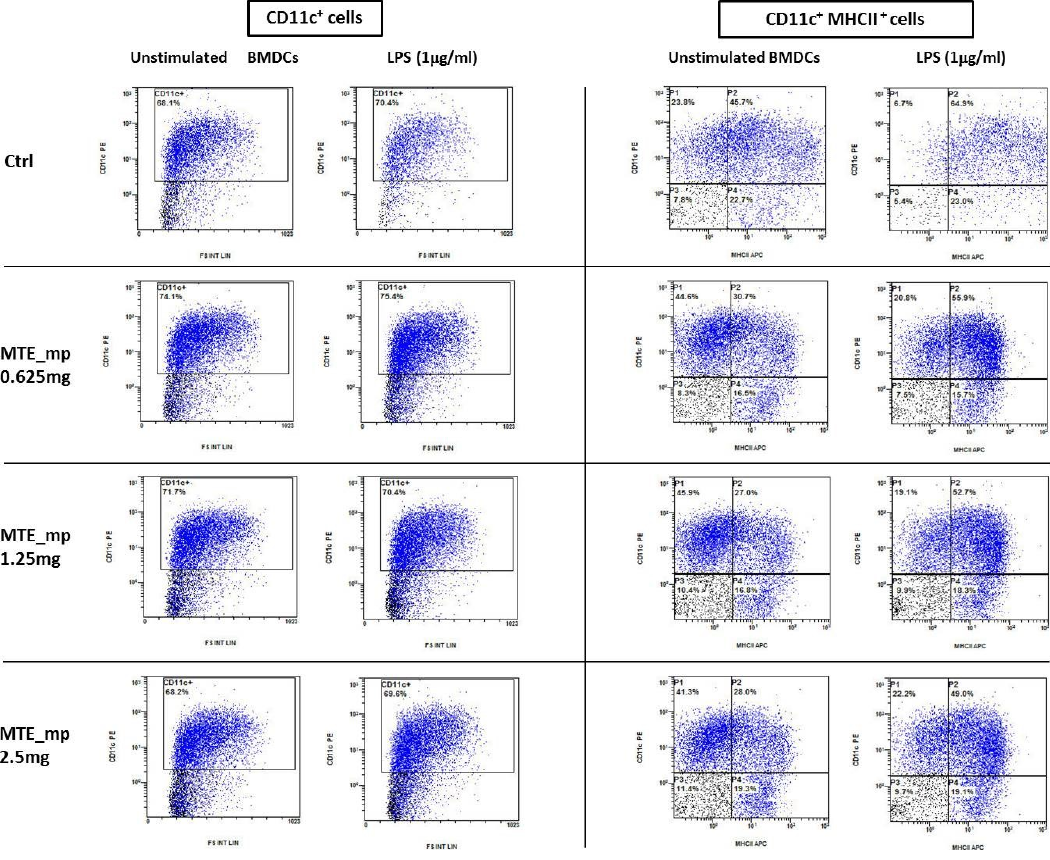
Figure 9. Dendritic cells (CD11C+) do not decrease much even at the highest concentration. MHCII expression decreases after LPS, this is consistent with less maturation and anti-inflammatory effect.